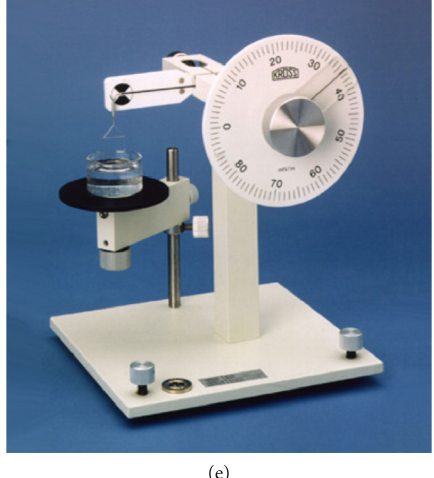
Figure 1: (a) A 50 ml density bottle. (b) Ostwald viscometer. (c) Seta cloud and pour point cryostat [20]. (d) Seta flash point tester [21]. (e)